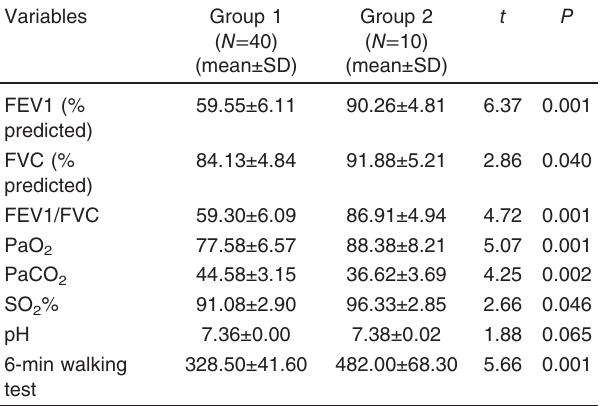
Table 2 Mean and SD of the studied variables in patients with chronic obstructive pulmonary disease and controls Variables